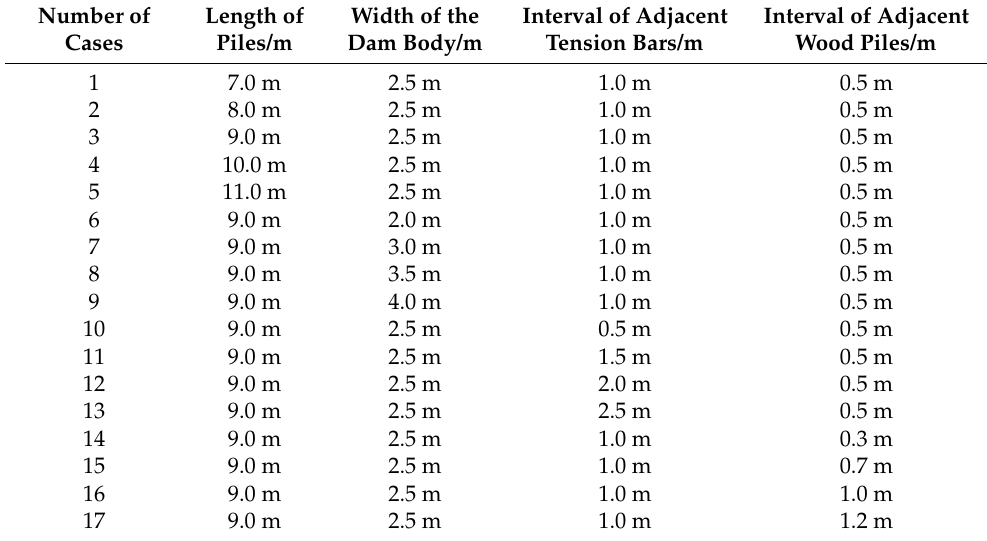
Table 3. 17 cofferdam structural forms of different parameters.